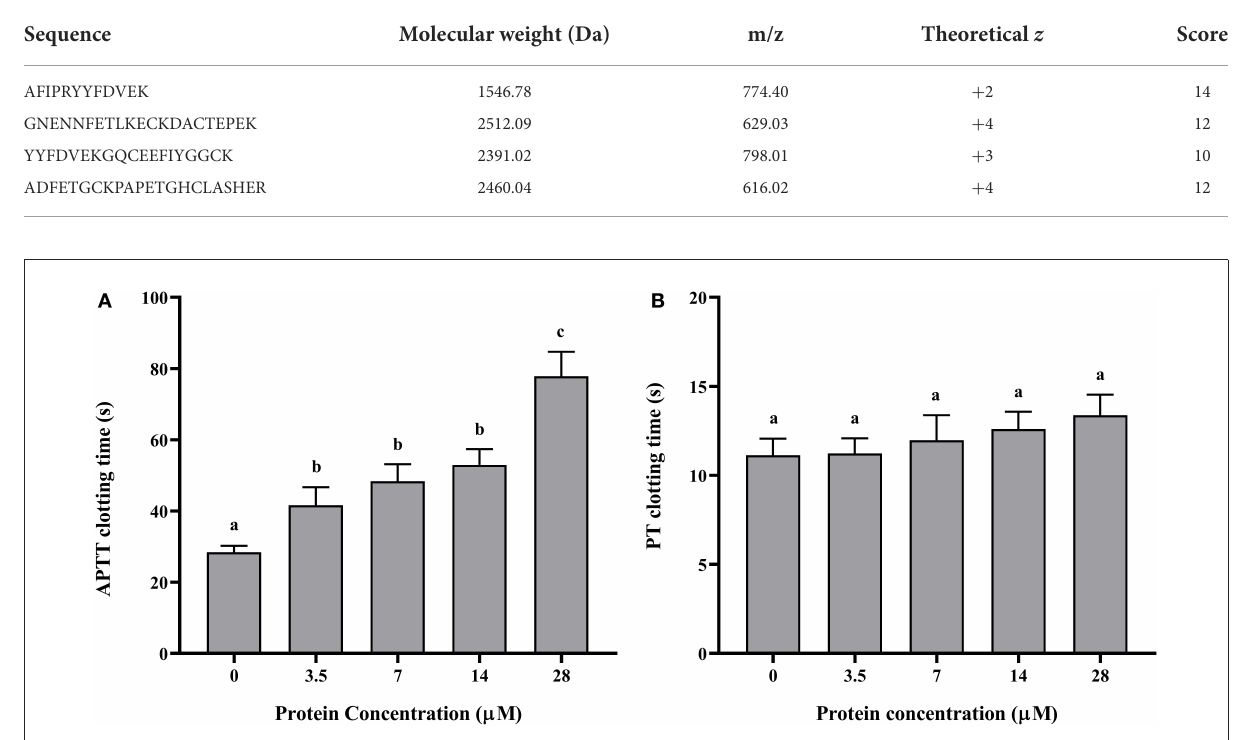
FIGURE5 (A) APTT and (B) PT determination of rDoenitin-1. Coagulation time at different concentrations (0, 3.5, 7, 14, and 28 µ M) of the recombinant protein. One-way ANOVA was conducted to analyze the data. Different letters indicate a significant difference between the two groups ( P <